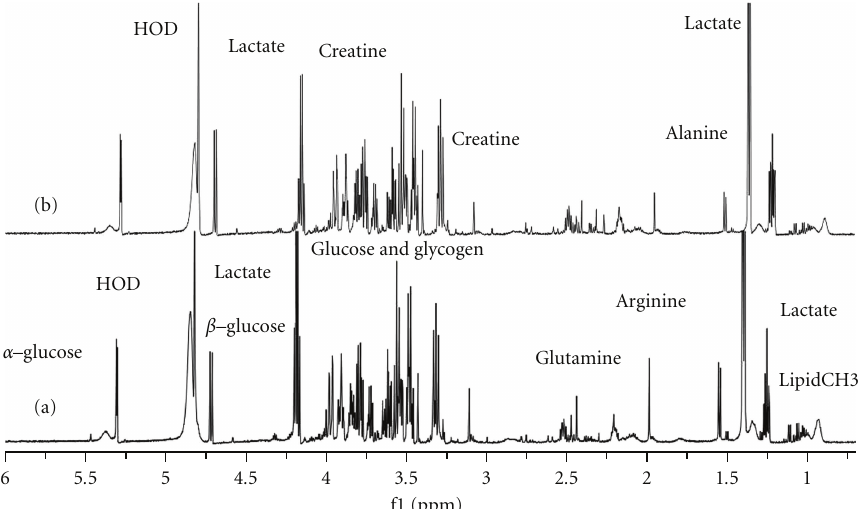
Figure 2: 600 MHz 1 H-NMR spectra of plasma samples from the pregnant mice in two groups: “a” showed the spectrum from one sample in the control group; “b” showed the spectrum from one sample in the DEX